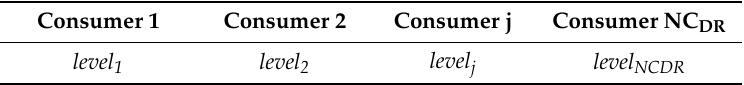
Table 3. The encoding used by a particle in the MOPSO